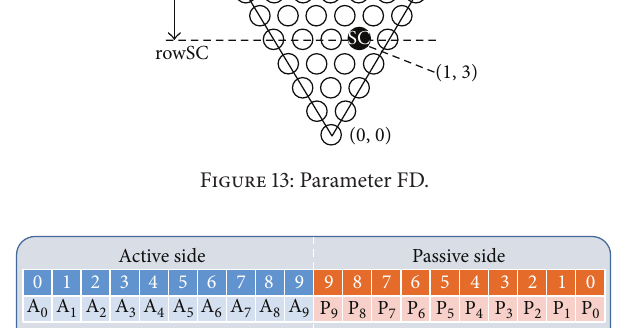
Figure 14: Logical expression of the